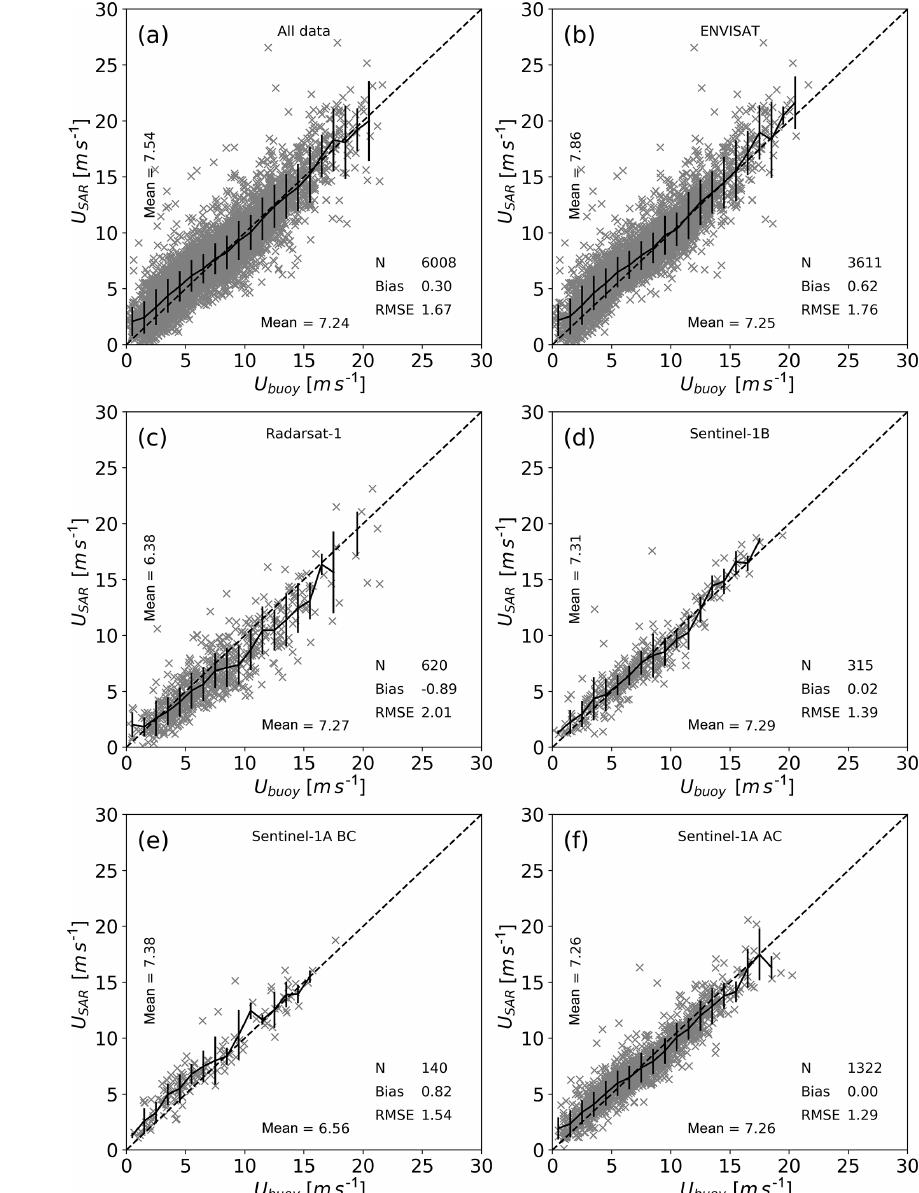
Figure 2. Scatter plots of SAR versus buoy winds at 10m with default SAR wind processing for (a) all data, (b) Envisat, (c) RADARSAT-1, (d) Sentinel-1 BC, (e) Sentinel-1 AC, and (f) Sentinel-1B. The black curves indicate the mean within each 1ms − 1 bin, and the vertical lines around the mean value indicate 1 standard deviation within this